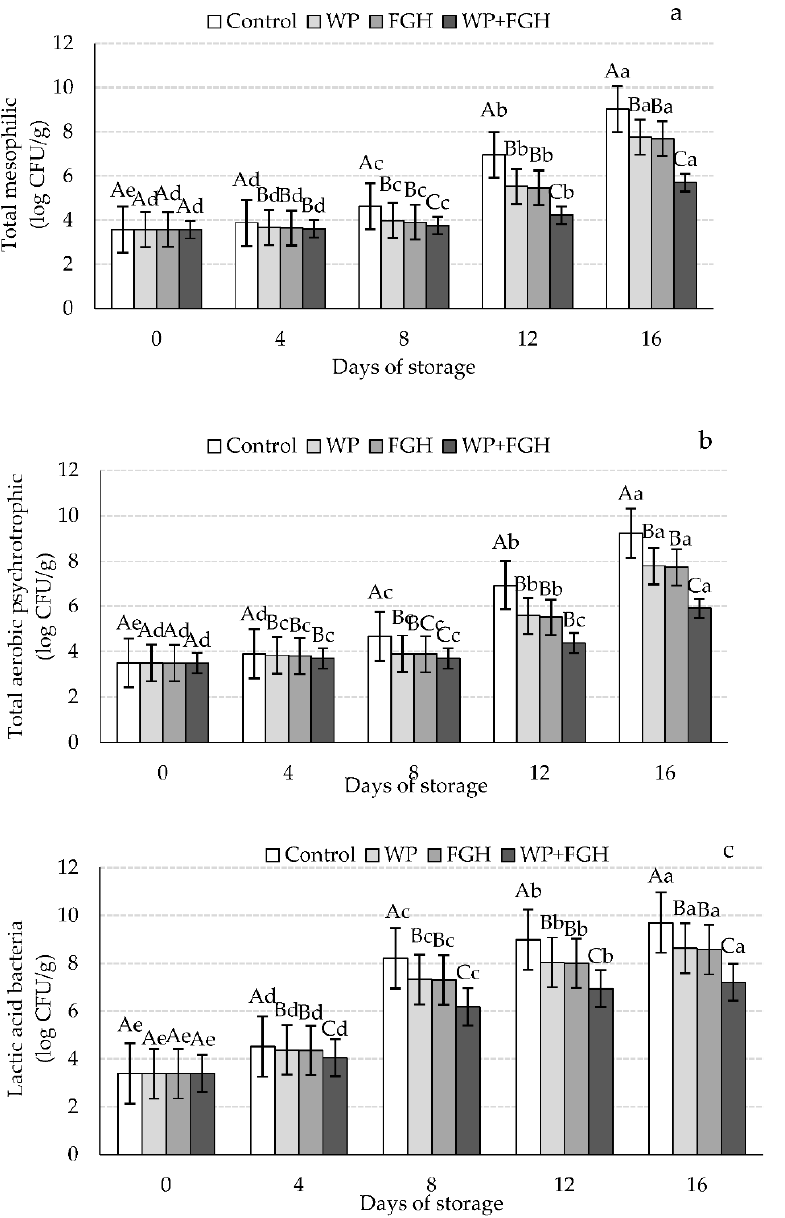
Figure 3. Changes in ( a ) total mesophilic, ( b ) total aerobic psychrotrophic, and ( c ) lactic acid bacterial counts in chicken breast fillets coated with whey protein (WP), fish gelatin hydrolysates (FGH), and a combination of whey protein and fish gelatin hydrolysates (WP + FGH) during cold storage at 4 ◦ C. Data are represented as mean ± standard deviation ( n = 3). Different uppercase letters represent statistically significant ( p < 0.05) differences in the microbial counts between days of storage within the same sample type. Different lowercase letters represent statistically significant differences ( p < 0.05) in microbial counts between different samples within the same storage time.